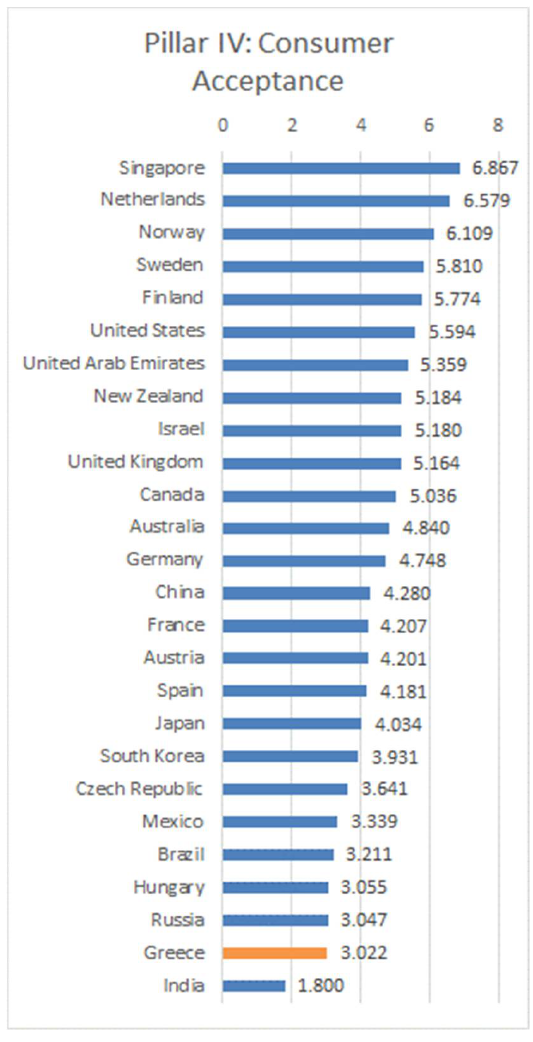
Figure 6. Greece’s AVRI listing in Pillar IV.